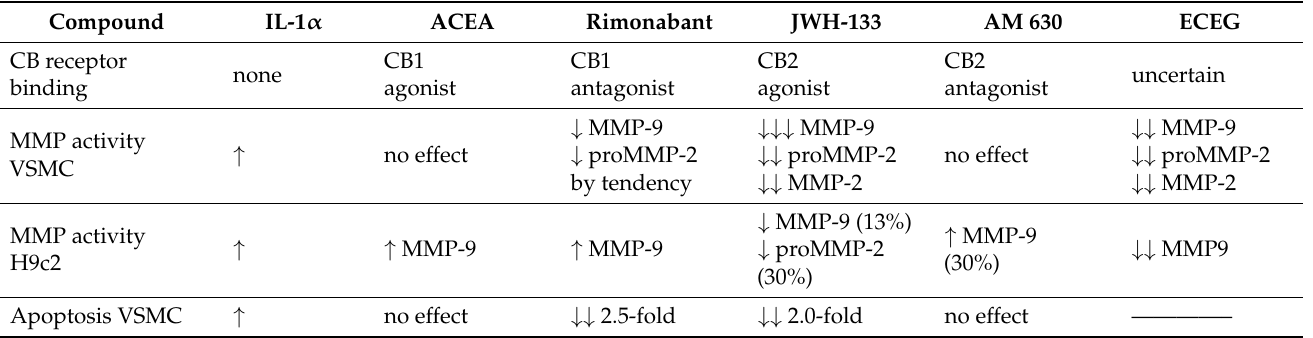
Table 1. Comparison of the effects of the CB1 and CB2 receptor agonists and antagonists on cytokine-induced MMPs secretion, apoptosis, glucose uptake and cell proliferation in VSMCs and cardiac H9c2 cells. ↑ —increase; ↑ —decrease.